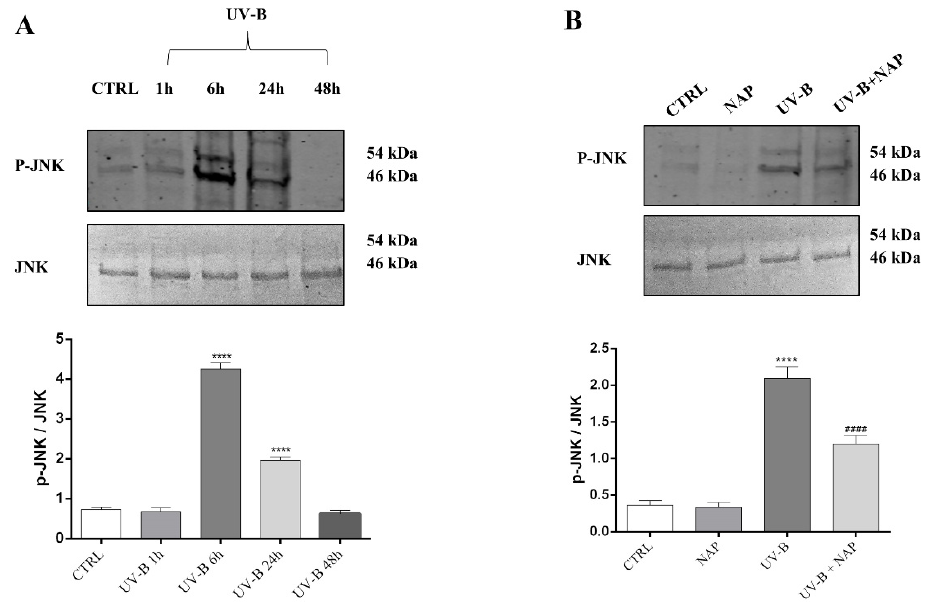
Figure 7. ( A ) Time-dependent effect of UV-B-induced JNK activation on corneal epithelial cells. The JNK phosphorylation was measured in SIRC cells at different time intervals after UV-B irradiation. ( B ) NAP treatment prevents UV-B-induced JNK phosphorylation in corneal epithelial cells. Representative immunoblots of JNK phosphorylation expression at 6 h in SIRC cells cultured in control medium (CTRL) or treated with 10 nM of NAP, or exposed to UV-B irradiation with or without 10 nM of NAP. The bar graphs show quantitative analysis of signals obtained by immunoblots resulting from three independent experiments. Relative band densities were quantified by using ImageJ software. Protein levels are expressed as arbitrary units obtained following normalization to total JNK, which was used as loading control. Data represent means ± SEM. **** p < 0.0001 vs. CTRL; #### p < 0.0001 vs. UV-B as determined by one-way ANOVA followed by Tukey’s multiple comparison test.